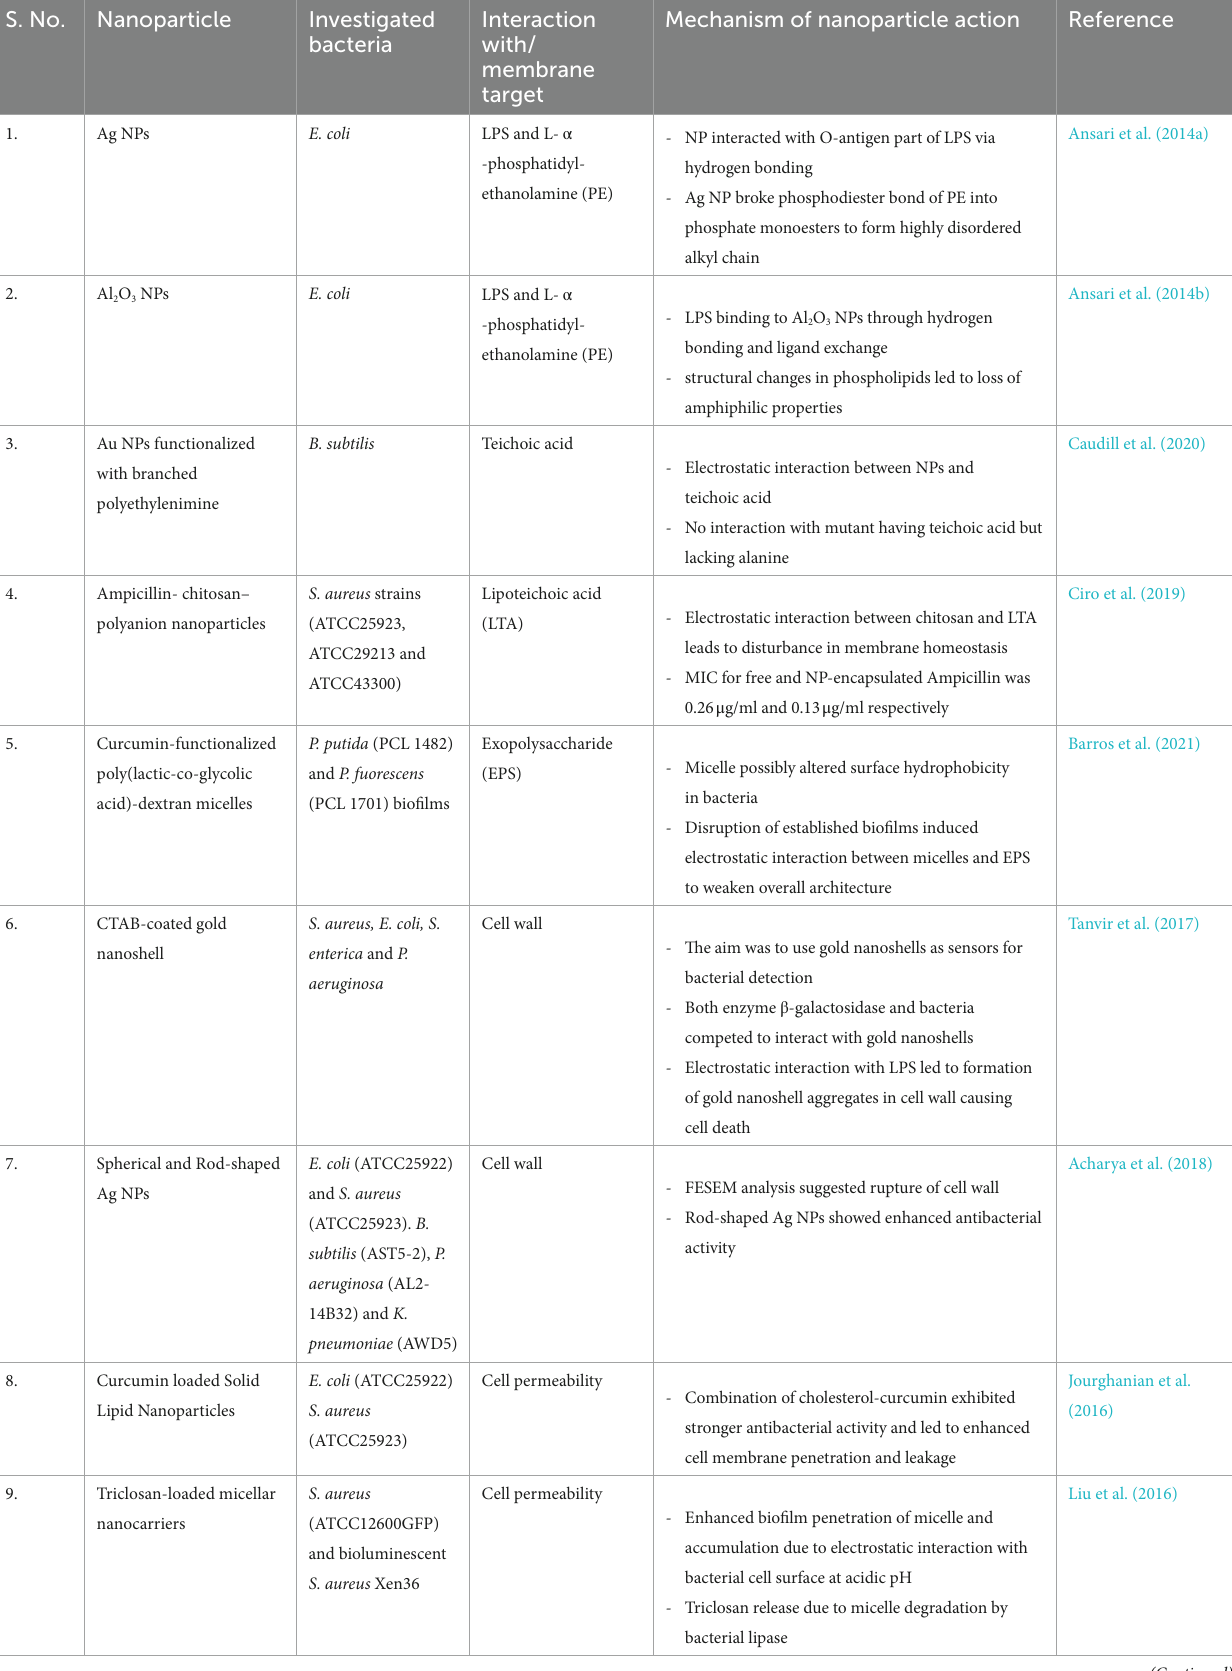
TABLE 2 Nanoparticles and their mechanism of action at the NP-bacterial membrane interface. S.